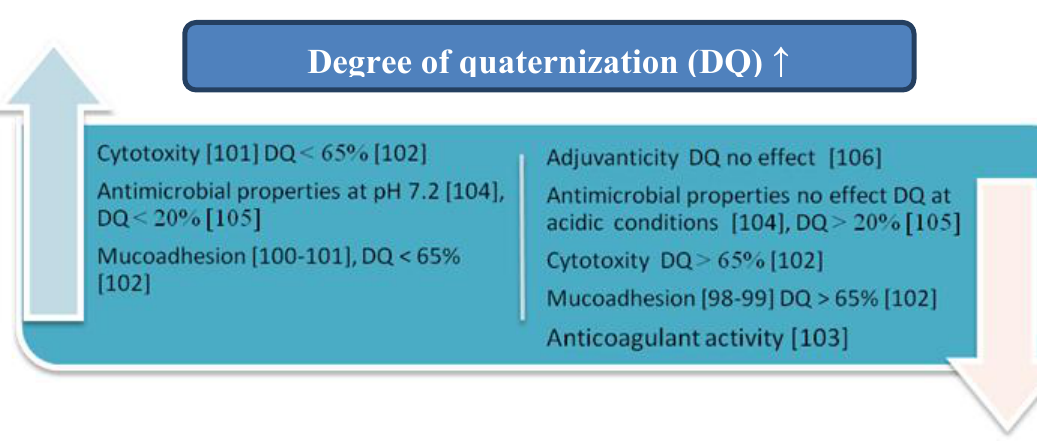
Figure 10. Influence of degree of quaternization on the selected physicochemical and biological properties of chitin/chitosan samples.